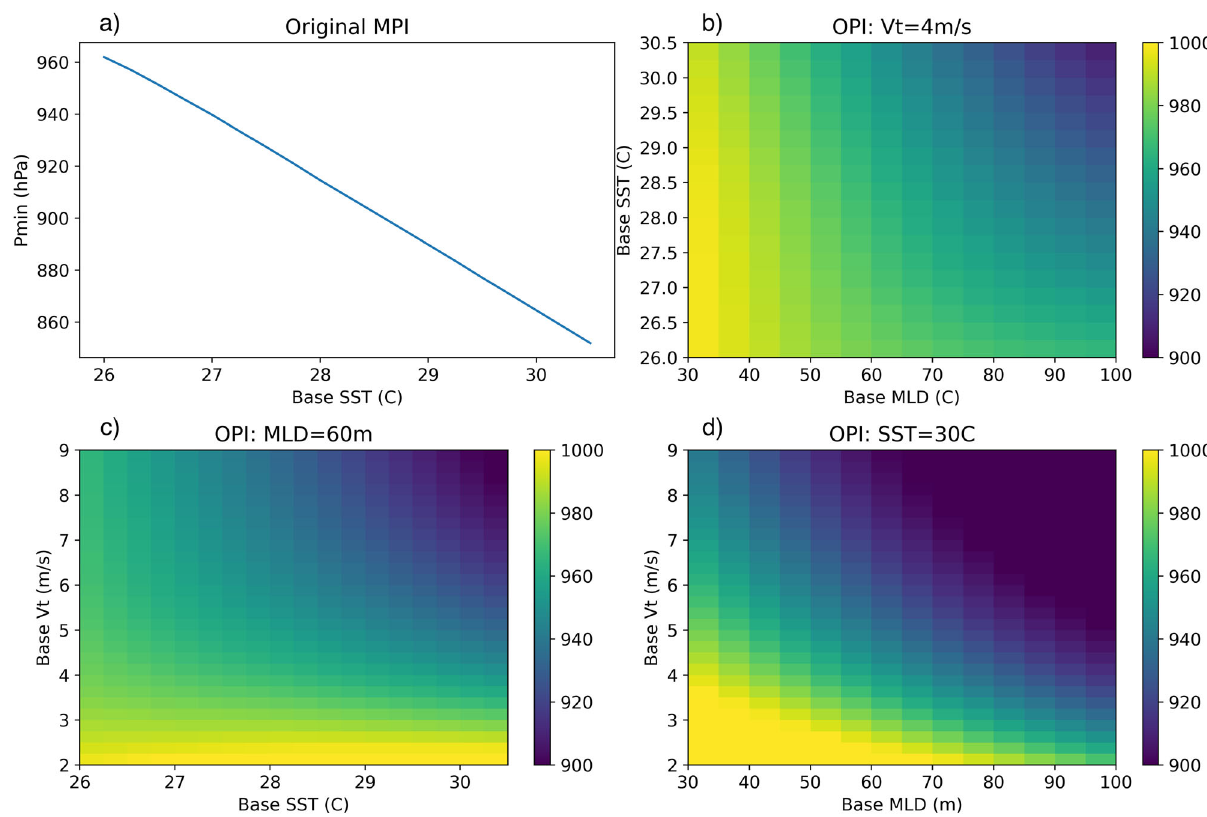
Fig. 1 Maximum potential intensity and ocean-aware potential intensity as functions of SST, MLD, and Vt. a MPI (hPa) as a function of SST, b OPI (hPa) as a function of initial SST and MLD for a constant translation speed of 4 m s − 1 , c OPI (hPa) as a function of initial SST and translation speed for a constant MLD of 60 m, and d OPI (hPa) as a function of translation speed and MLD for a constant SST of 30